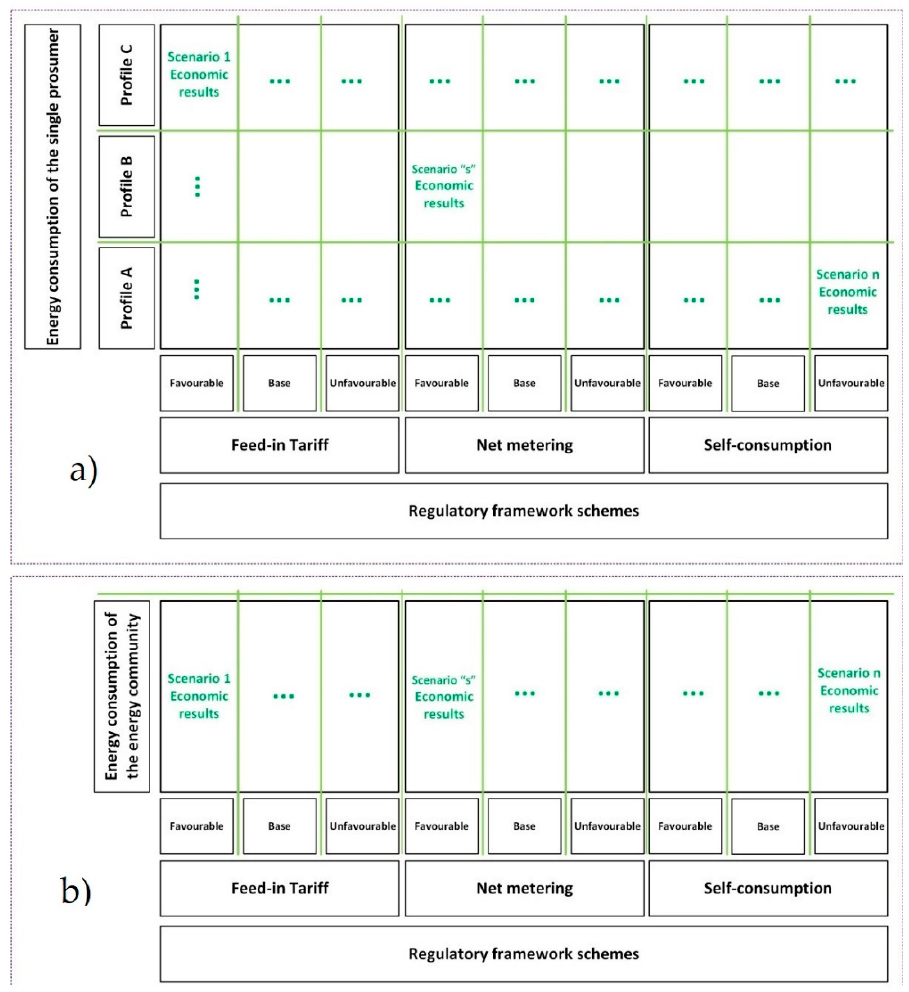
Figure 6. What-if analysis and scenarios under consideration, for the individual case ( a ) and the energy community ( b ). Source: self-elaboration.